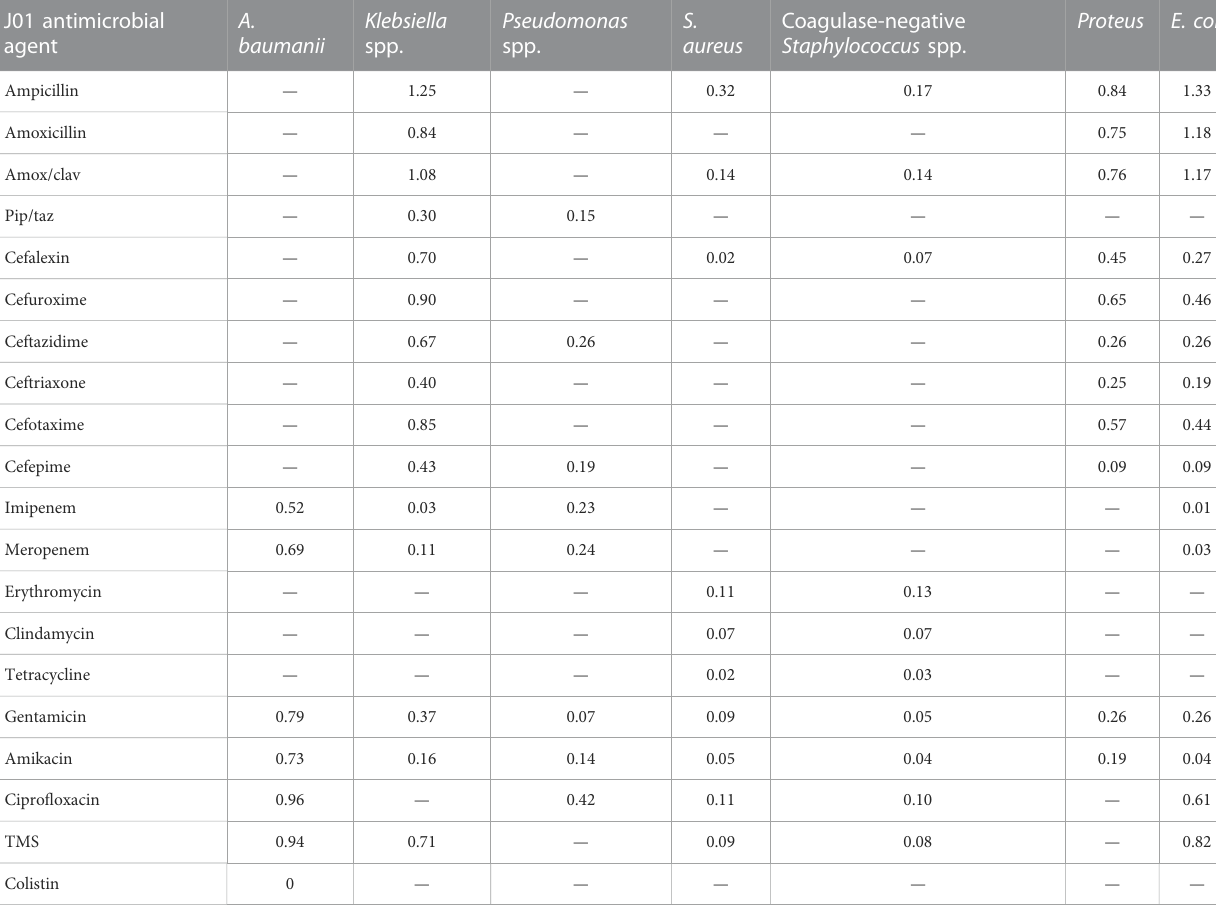
TABLE 4 Resistance density per 1000 patient-days per year according to the most common multiresistant strains of bacteria at HSAL Doboj in 2021. J01 antimicrobial agent